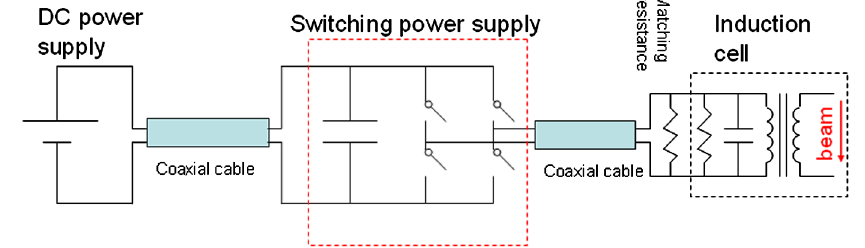
FIG. 27. An equivalent circuit for the induction acceleration